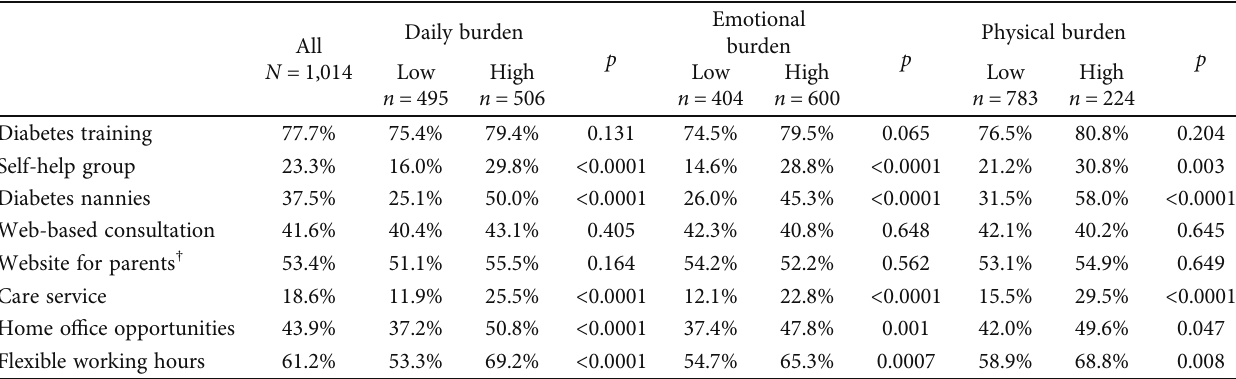
Table 4: Frequency of diabetes support requested by all parents and by low- and high-burden parents living with a child with type 1